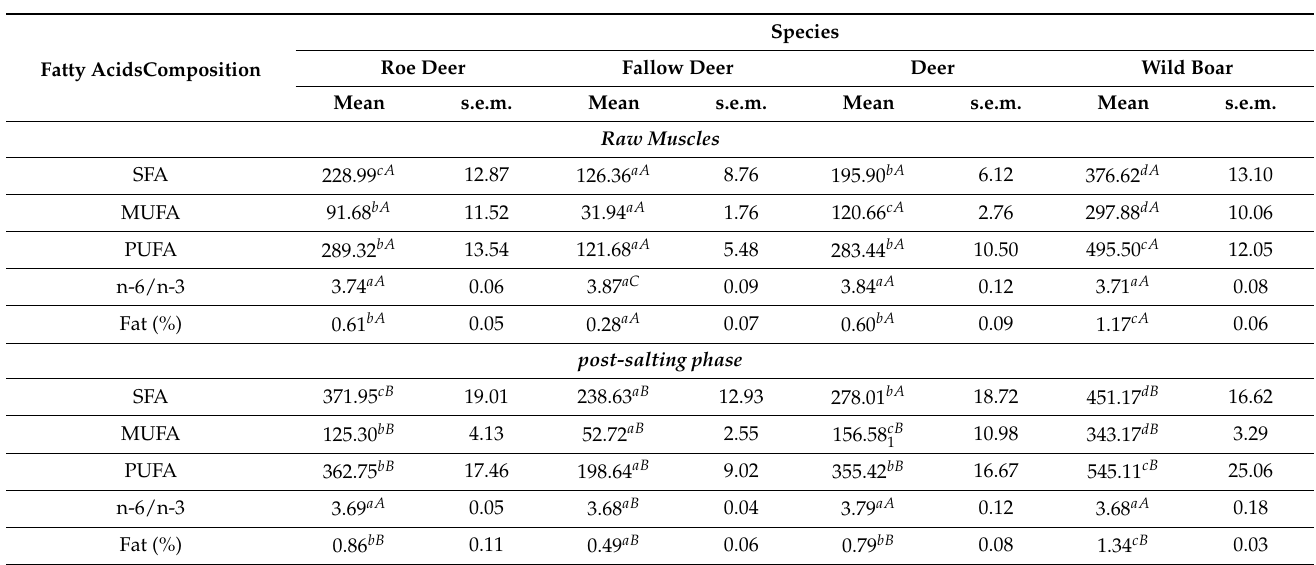
Table 2. Fat content (% of total wet weight) and fatty acids composition (mg/100 g muscle tissue) of SM ( semimembranosus ) venison